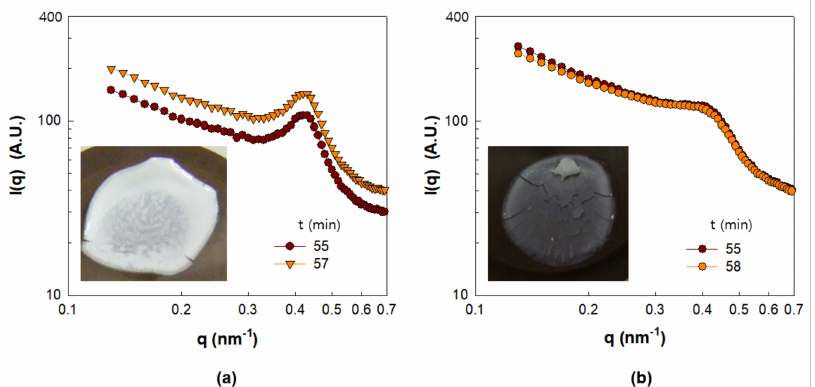
Figure 9. SAXS intensity of silica-PVA film in the range of drying time from 55 to 58 min. ( a ) Γ 0.03 and ( b ) Γ